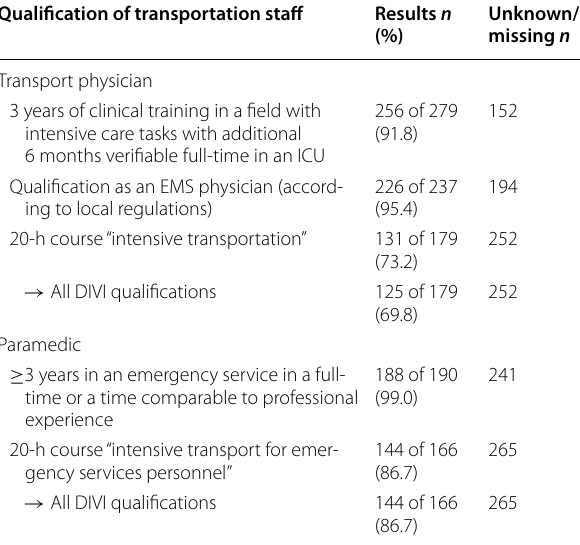
Table 3 Qualification of transportation staff